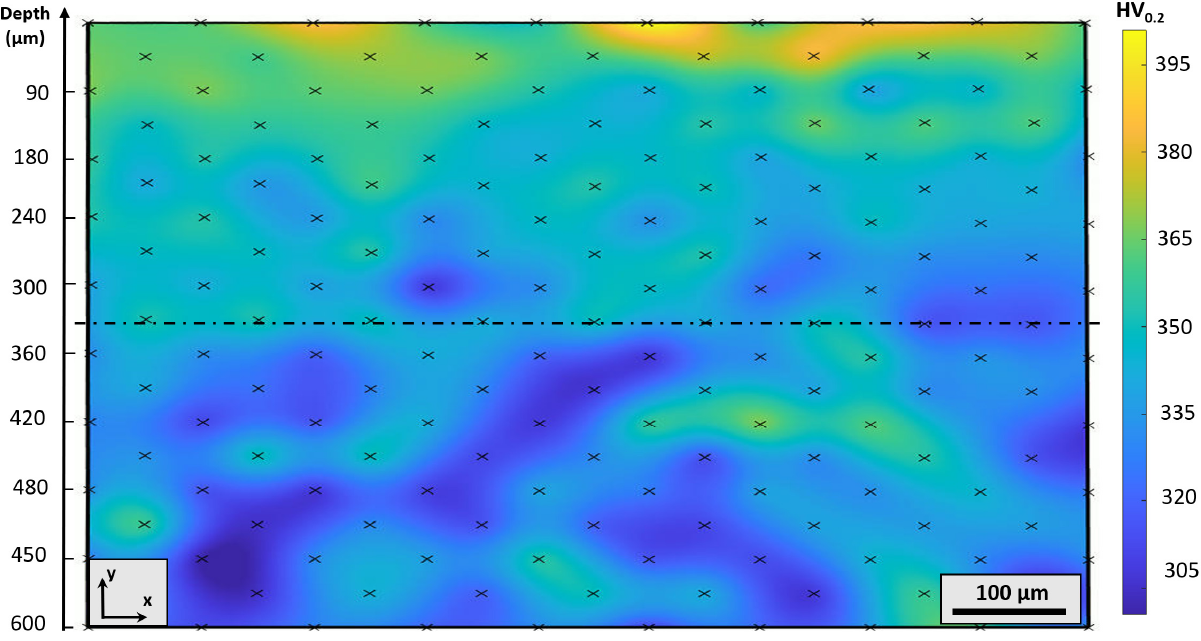
Figure 17. Cross-sectional hardness map of shot-peened Cp-Ti sample, indicating surface/subsurface hardening of the material with shot peening. X marks indicate the location of hardness impressions, and dashed line shows the depth of hardened layer, which is around 330 μ m thick.